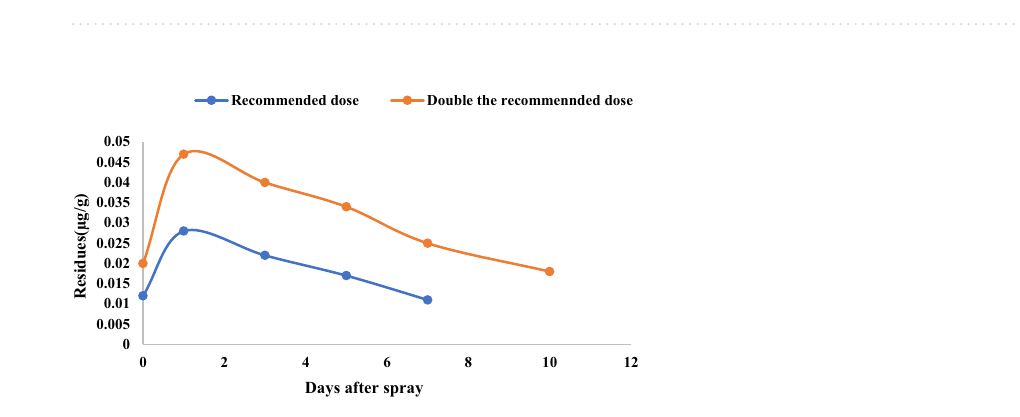
Figure 4. Dissipation of chlorantraniliprole 18.5% SC in paddy soil during rabi at recommended dose and double the recommended dose.